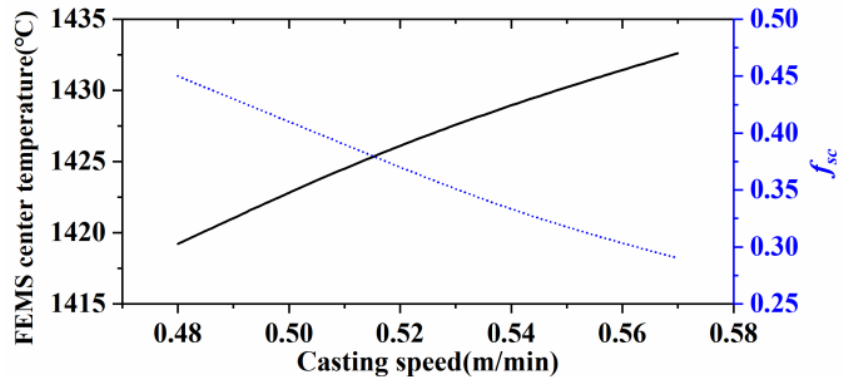
Figure 8. FEMS center temperature under different casting speeds.